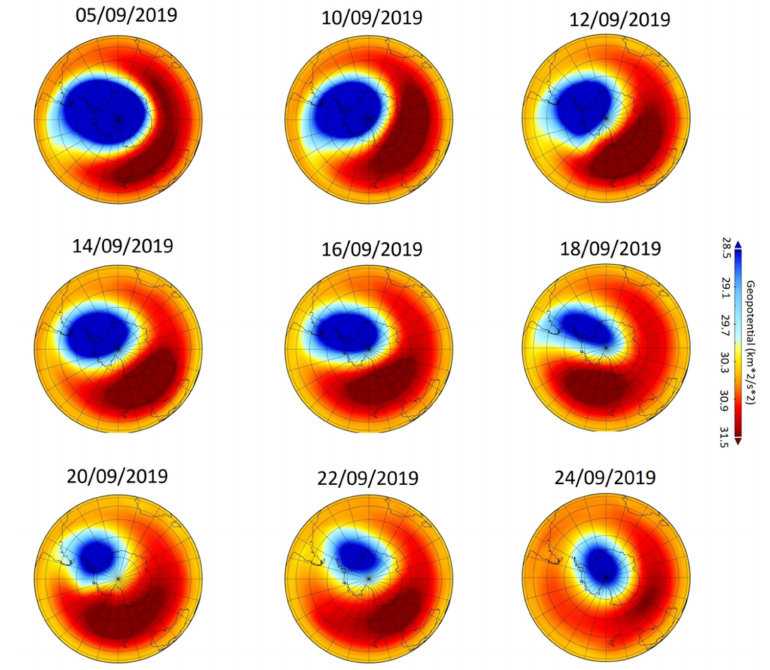
Figure 11. Vertical profile of polar temperature during SSW in 2019 in the SH.